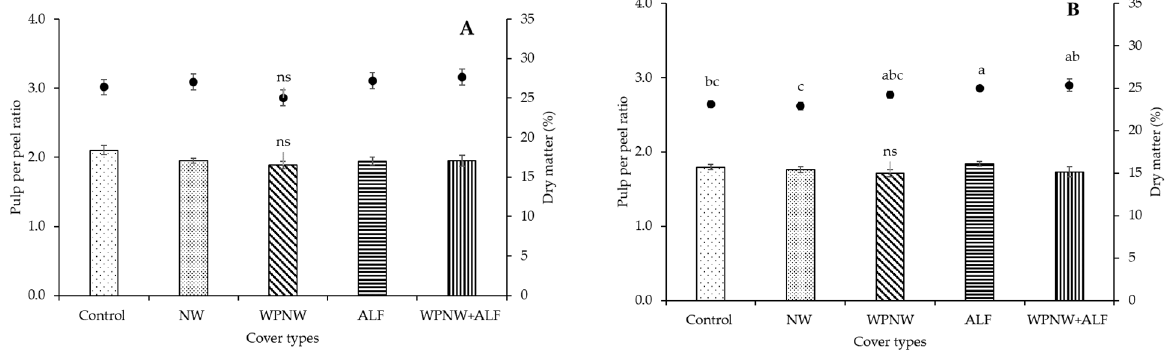
Figure 5. Pulp-to-peel ratio and dry matter of Cavendish banana fruit for mature green stage at the winter ( A ) and summer ( B ) trials. (Different letters indicate significant differences at p < 0 . 05).